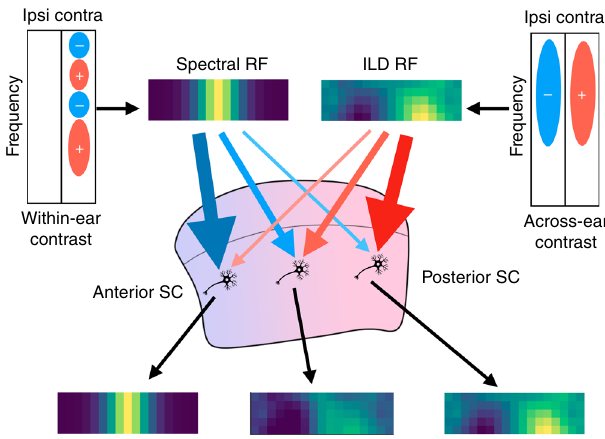
Fig. 6 Combination of spectral cues and ILDs are used to form a topographic map of azimuthal auditory space. Within-ear contrast of the input spectrum is used to provide an excitation to sound from the frontal fi eld, while across-ear contrast (ILD) in a broad frequency range provides the excitation to sound from the lateral fi eld (blue circles with − signs denote frequency bands that negatively in fl uence the response; red circles with + signs denote frequency bands that positively in fl uence the response). Neurons in the SC receive these inputs with different weights depending on their anteroposterior position. This progressive change of the weight creates the auditory topographic map of azimuthal space in the mouse